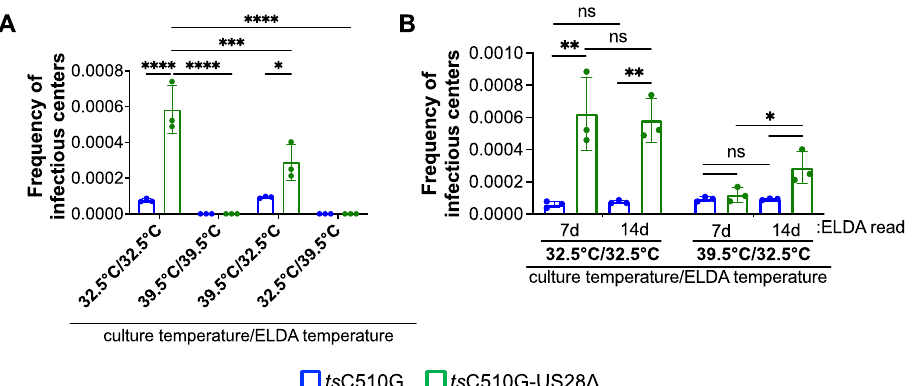
Figure 4. ts C510G-US28∆-infected Kasumi-3 cells display a decrease in the frequency of infectious centers at the non-permissive temperature. Kasumi-3 cells were infected (moi = 1.0 TCID 50 /cell) with ts C510G or ts C510G-US28∆ and maintained in conditions favoring latency at the indicated culture temperature (7 d). Each infected population was then co-cultured with naïve NuFF-1 cells (14 d) at the indicated temperature (ELDA temperature). ( A ) The frequency of infectious centers was calculated by ELDA 14 d post-co-culture. ( B ) The infected cells cultured at 32.5 C and 39.5 C that were shifted to 32.5 C were quantified by ELDA at 7 d post-co-culture. Note that the 14 d data are replotted in this graph and identical to the data shown in ( A ). ( A,B ) Each data point (cir- cles) is the mean of three technical replicates. Error bars indicate SD of three biological replicates. The statistical significance was calculated using two-way ANOVA followed by Tukey’s post hoc analysis. * p < 0.05, ** p < 0.01, *** p = 0.0005, **** p < 0.0001 4. Discussion Herein we generated two novel recombinant viruses, TB40/E gfp C510G ( ts C510G) and TB40/E gfp C510G-US28 ( ts C510G-US28 ), which harbor the C510G mutation in the UL122 sequence, shown previously to confer a temperature-sensitive mutation [22]. Our findings in lytically infected fibroblasts (Figure 1) confirmed previous findings from Hei- der et al., who showed this mutation in the CMV strain, Towne, resulting in the inability of the virus to replicate at the non-permissive temperature [22]. We also show that these newly generated viruses in the TB40/E background support the infection of hematopoietic cells, including primary cord blood-derived CD34 + HPCs and the CD34 + cell line, Kasumi- 3 cells (Figure 3). Importantly, we demonstrate that ts C510G undergoes latency and reac- tivation at the permissive temperature, but not when maintained at the non-permissive temperature (Figure 3). Importantly, ts C510G-US28 fails to maintain latency under these conditions (Figure 4), consistent with previous findings [9-12, 15, 16]. However, we show ts C510G-US28 -infected Kasumi-3 cells cultured under latent conditions at the non-per- missive temperature show a significant reduction in the frequency of infectious centers (Figure 4), suggesting that this virus could prove useful as a tool to study US28-specific regulated host and viral factors without inducing significant lytic replication. CMV latent infection is maintained in HPCs and monocytes, while more differenti- ated hematopoietic cells, including macrophage and dendritic cells, support viral reacti- vation and lytic replication. The differentiation of both HPCs and monocytes down the lineage to the more mature cell types triggers viral reactivation. Thus, it is clear that the differentiation stage of the hematopoietic cell correlates with the infection stage of the virus. It is therefore possible that, due to the lytic-like phenotype that results from infec- tion with a US28 mutant virus in HPCs and monocytes, the cellular milieu changes to one that supports reactivation and lytic infection, rather than latency. Such alterations in the